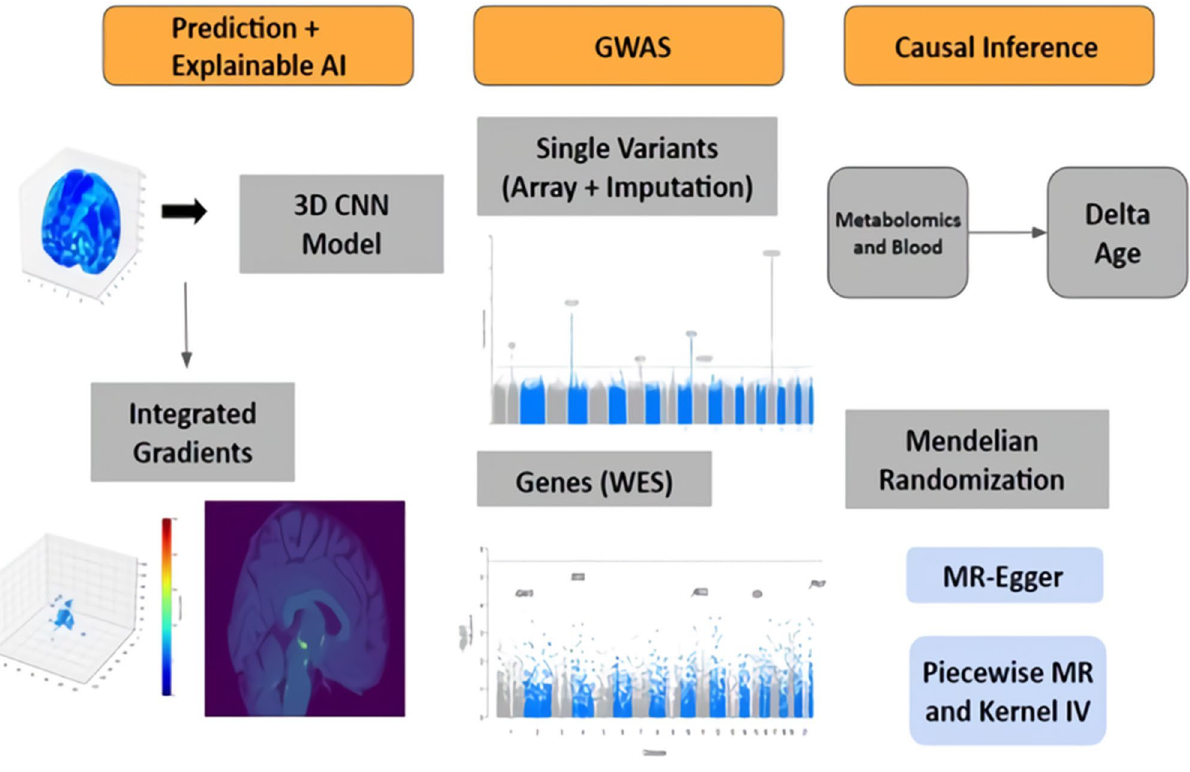
Figure 1. Overview of the analysis.